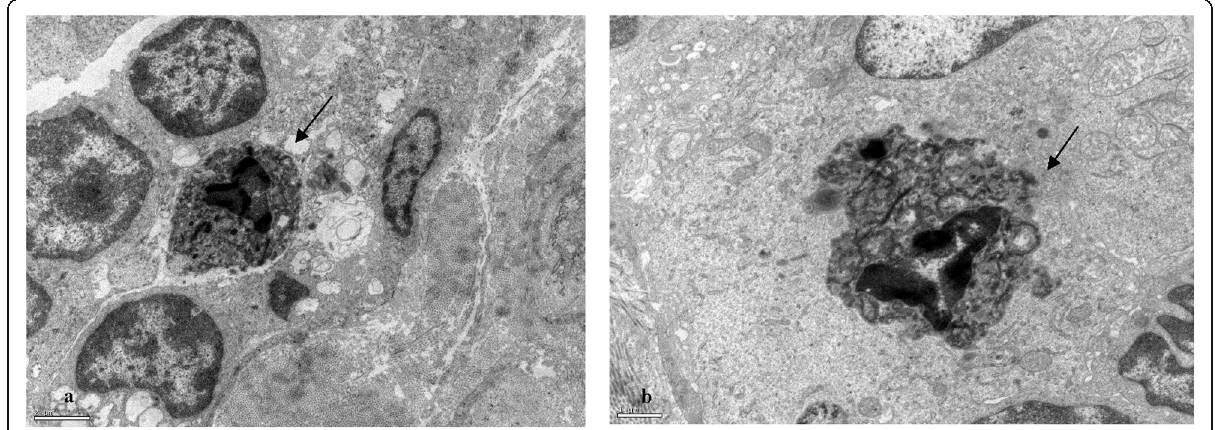
Fig. 2 In the tissue adjacent to the cautery margin, a few apoptotic bodies were identified (arrows) showing cellular shrinkage, chromatin condensation, fragmentation, and leaky nuclear envelopes. a Electron microscopy, × 8000, on the 15 W side. b Electron microscopy, × 12000, on the 25 W